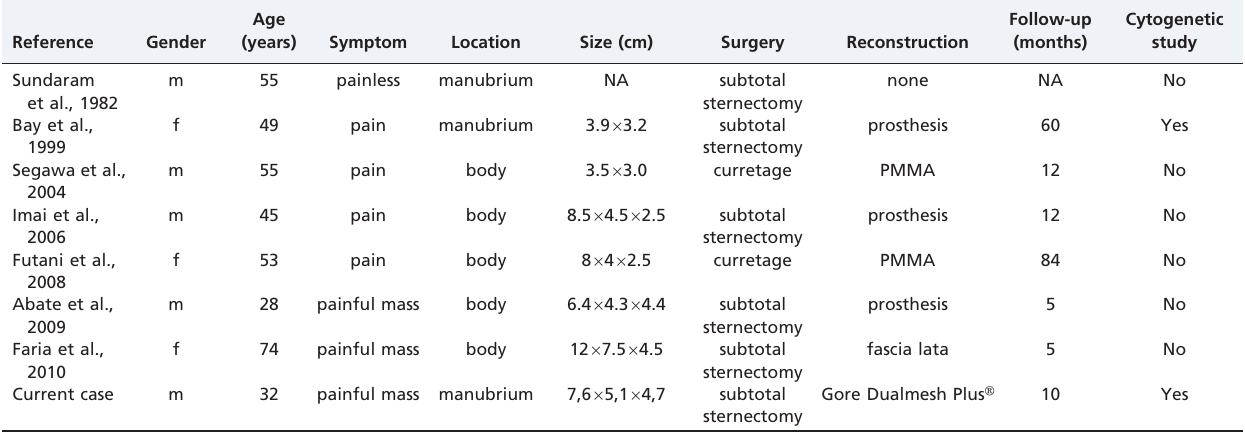
Table 1 - Reported cases of giant cell tumor (GCT) of the